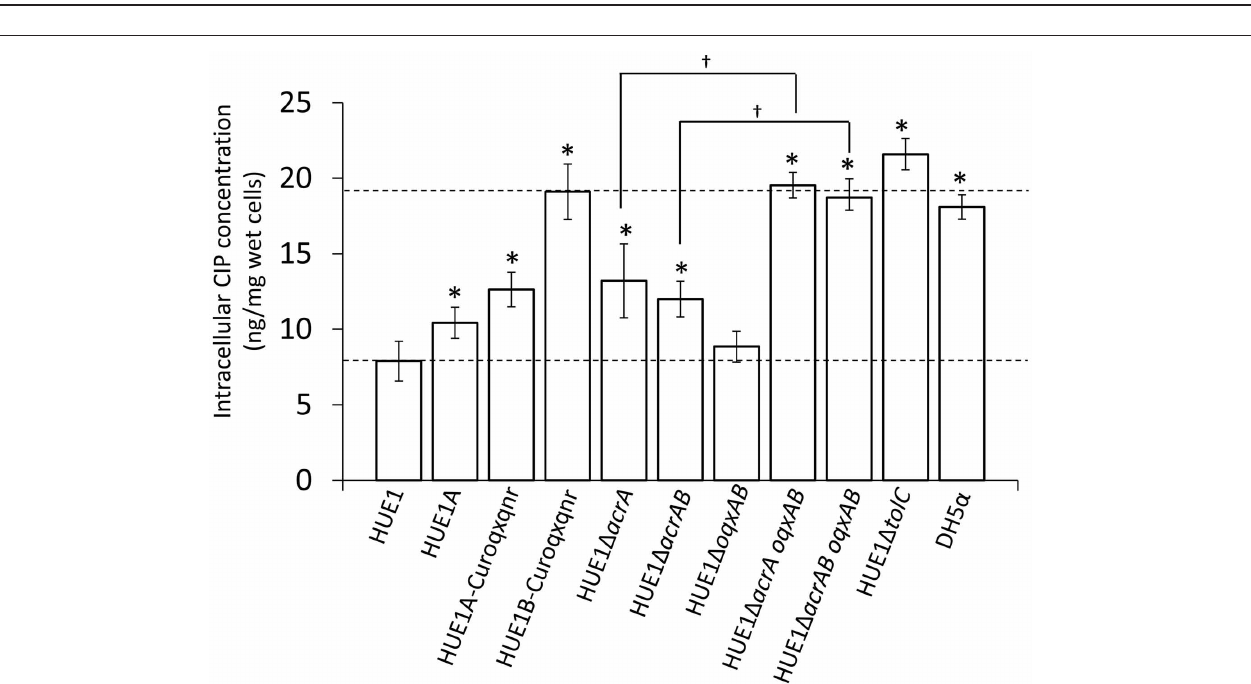
FIGURE 3 | mRNA expression levels of marA , acrA , and acrB in HUE1 and its acrR or marR transformants. The values indicate the expression levels of indicated genes relative to those in HUE1 (fold-changes). White, HUE1; gray, HUE1-pUC19; diagonal line, HUE1-wt- acrR (HUE1 strain